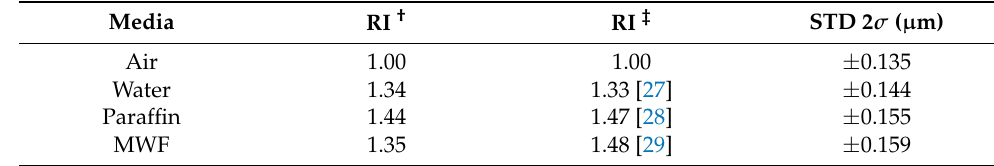
Table 1. Comparison of residual error from 1st-order polynomial fit across specified operating media, with RI values taken from measured amplification factors and from the